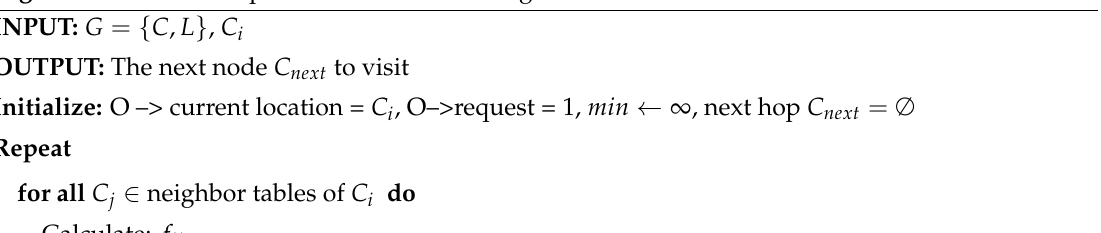
Algorithm 1 Least cost path recommendation